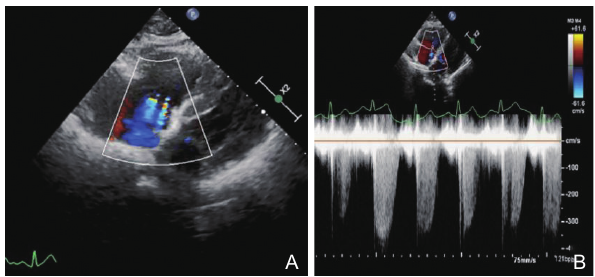
A Figure 15 COVID-19 with pulmonary hypertension. The same patient as in Figure 14B, (A) Color Doppler echocardiography showing moderate tricuspid regurgitation; (B) The increased pulmonary arterial systolic blood pressure was estimated by tricuspid regurgitation pressure gradient.